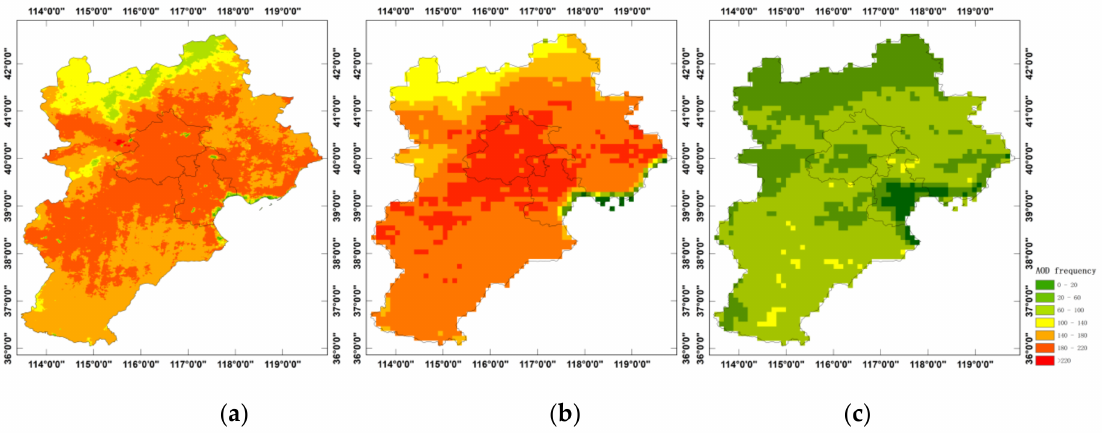
Figure 3. Observed frequencies of MAIAC ( a ), DB ( b ) and DT ( c ) AOD data in BTH during 2017.